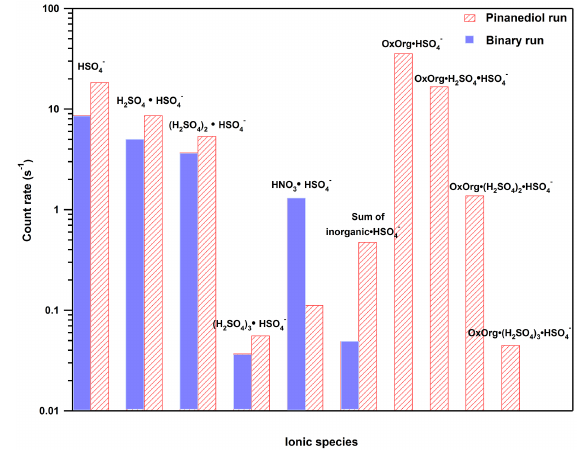
Figure 3. Example of the effect of the pion beam on the HSO − count rate during a nucleation experiment. During the second part of this experiment (16:00UTC and later), the CIMS corona ion source was switched off and only ions from the chamber were detected.